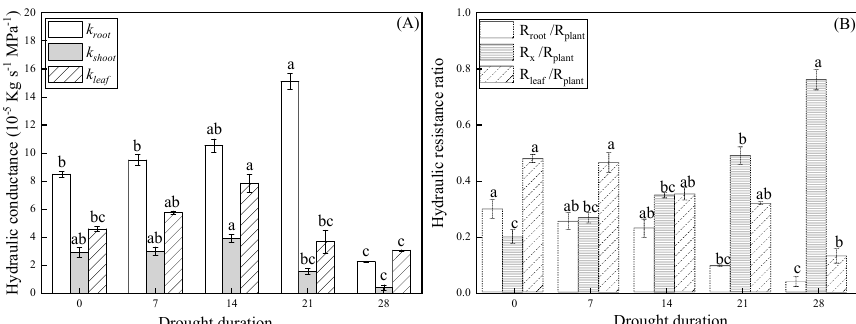
Figure 3. Changes in hydraulic conductance ( A ) and hydraulic resistance ratio ( B ). ( A ): k root (open bars) indicate hydraulic conductance of whole roots, k shoot (light-shaded bars) indicate hydraulic conductance of whole shoots, k leaf (hatched bars) indicate hydraulic conductance of leaves. ( B ): R root / R plant (open bars) indicate hydraulic resistance ratio of whole roots to whole plant, R x / R plant (light-shaded bars) indicate hydraulic resistance ratio of bare shoots to whole plant, R leaf / R plant (hatched bars) indicate the resistance ratio of leaves to the whole plant. Di ff erent lower-case letters denote significance levels based on ANOVA (Analysis of variance) post hoc means with LSD (least significant di ff erence test) analysis ( p < 0.05). Data are means with standard error.